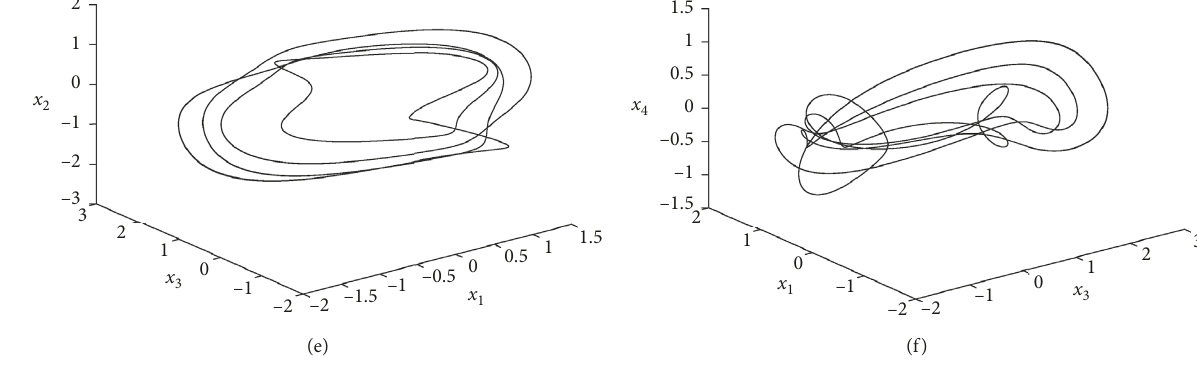
Figure 12: Periodic-4 motion occurs when b